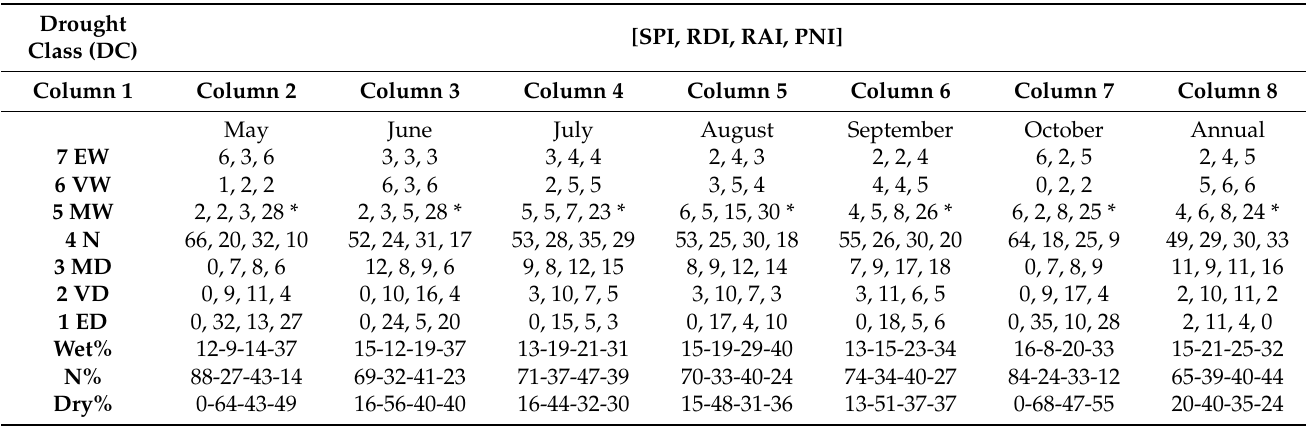
Table 4. Seasonal (monthly and annual) drought frequencies for SPI, RDI, RAI, and PNI.